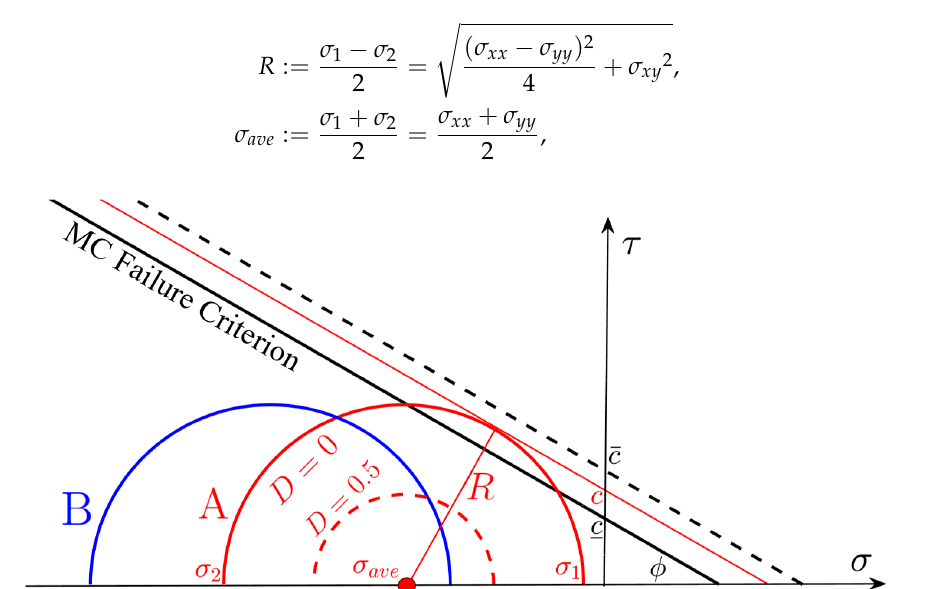
Figure 1. Mohr-Coulomb failure criterion and scalar stress c for a given stress state.